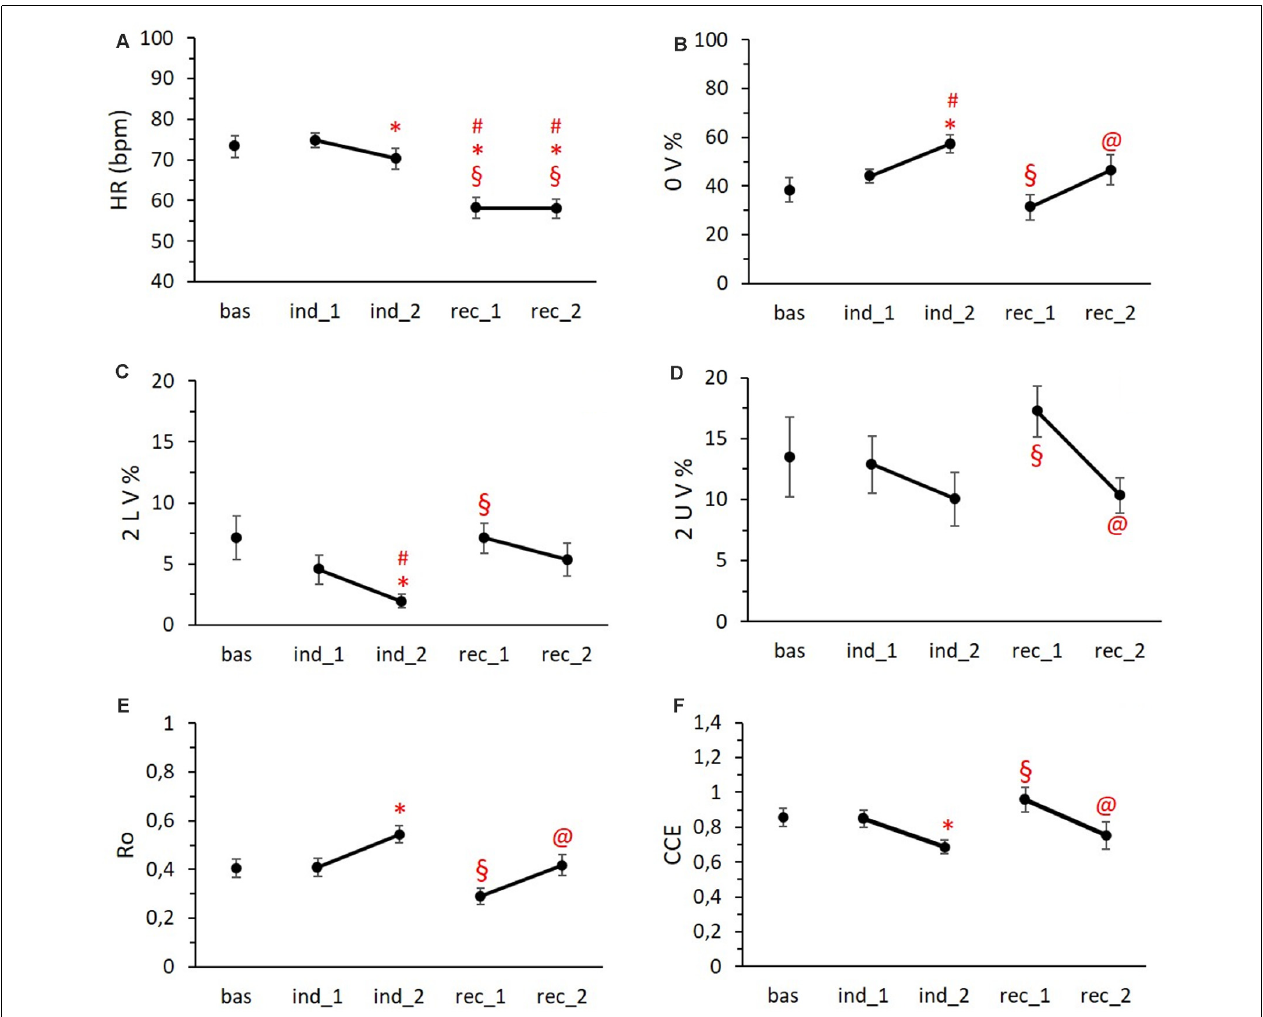
FIGURE 5 | HR trend (A) , symbolic metrics trends (B,C,D) , and complexity metrics trends (E,F) during the different phases of the protocol. Data are reported as means ± standard errors. # vs. Bas, ∗ vs. Ind1 § vs. Ind1, @ vs. Rec1. Abbreviations: HR = heart rate; 0 V% = pattern with no variations; 2 LV% = pattern with two like variations; 2 UV% = pattern with two unlike variations; Ro = index of regularity; CCE = corrected conditional